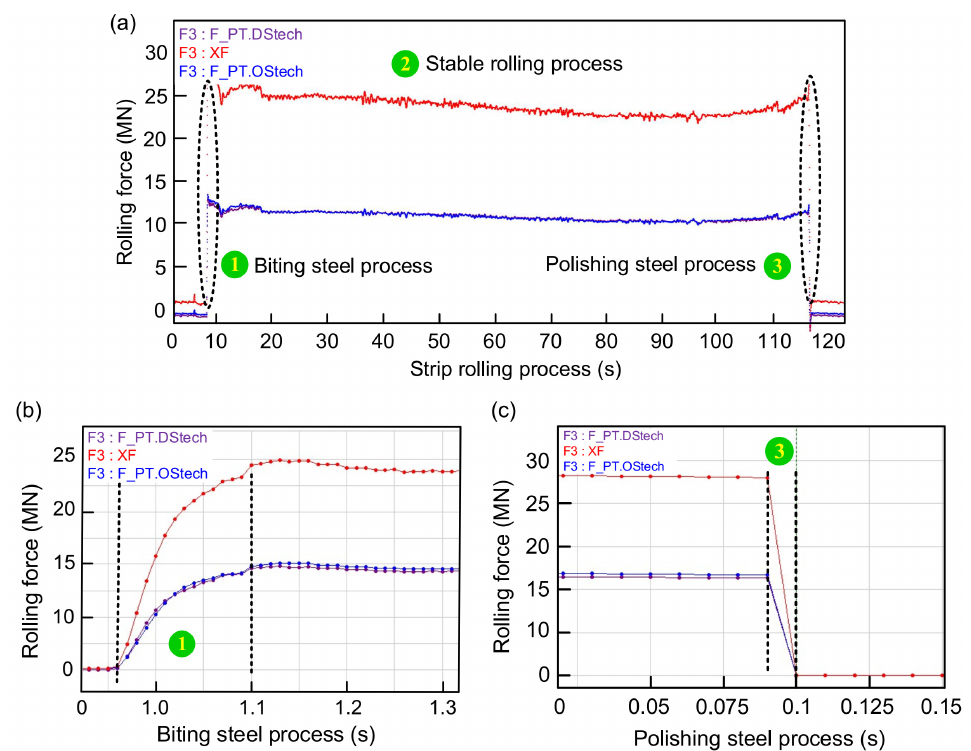
Figure 6. The change in rolling force when the finished product is 1.6 mm: ( a ) total rolling force, ( b ) biting rolling force, and ( c ) polishing rolling force.